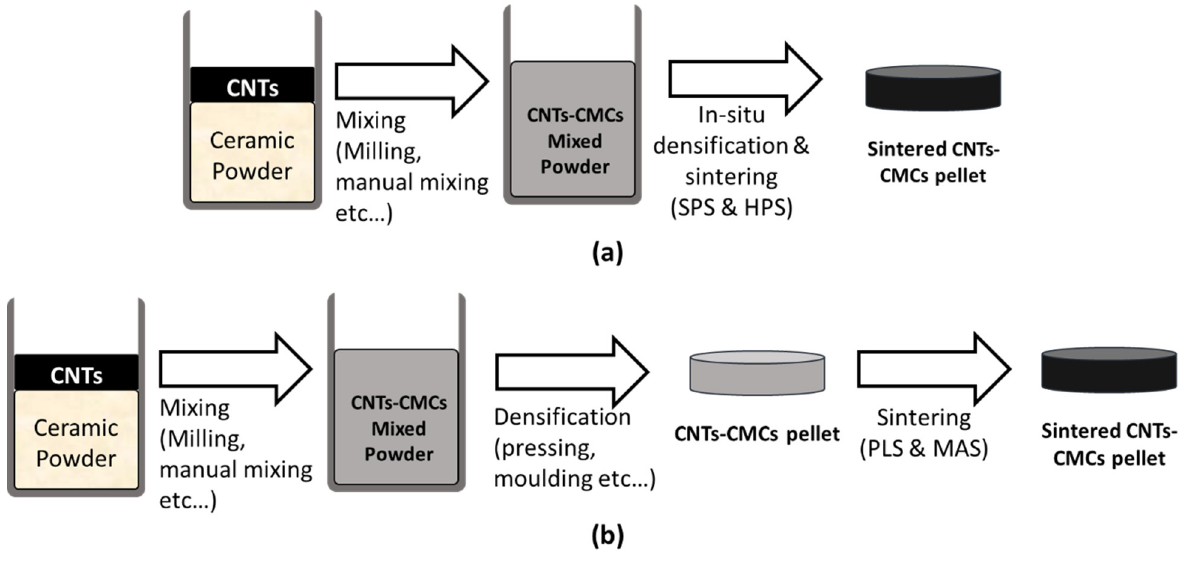
Figure 3. Conceptual setup for ( a ) the two-step and ( b ) the three-step powder processing methods.